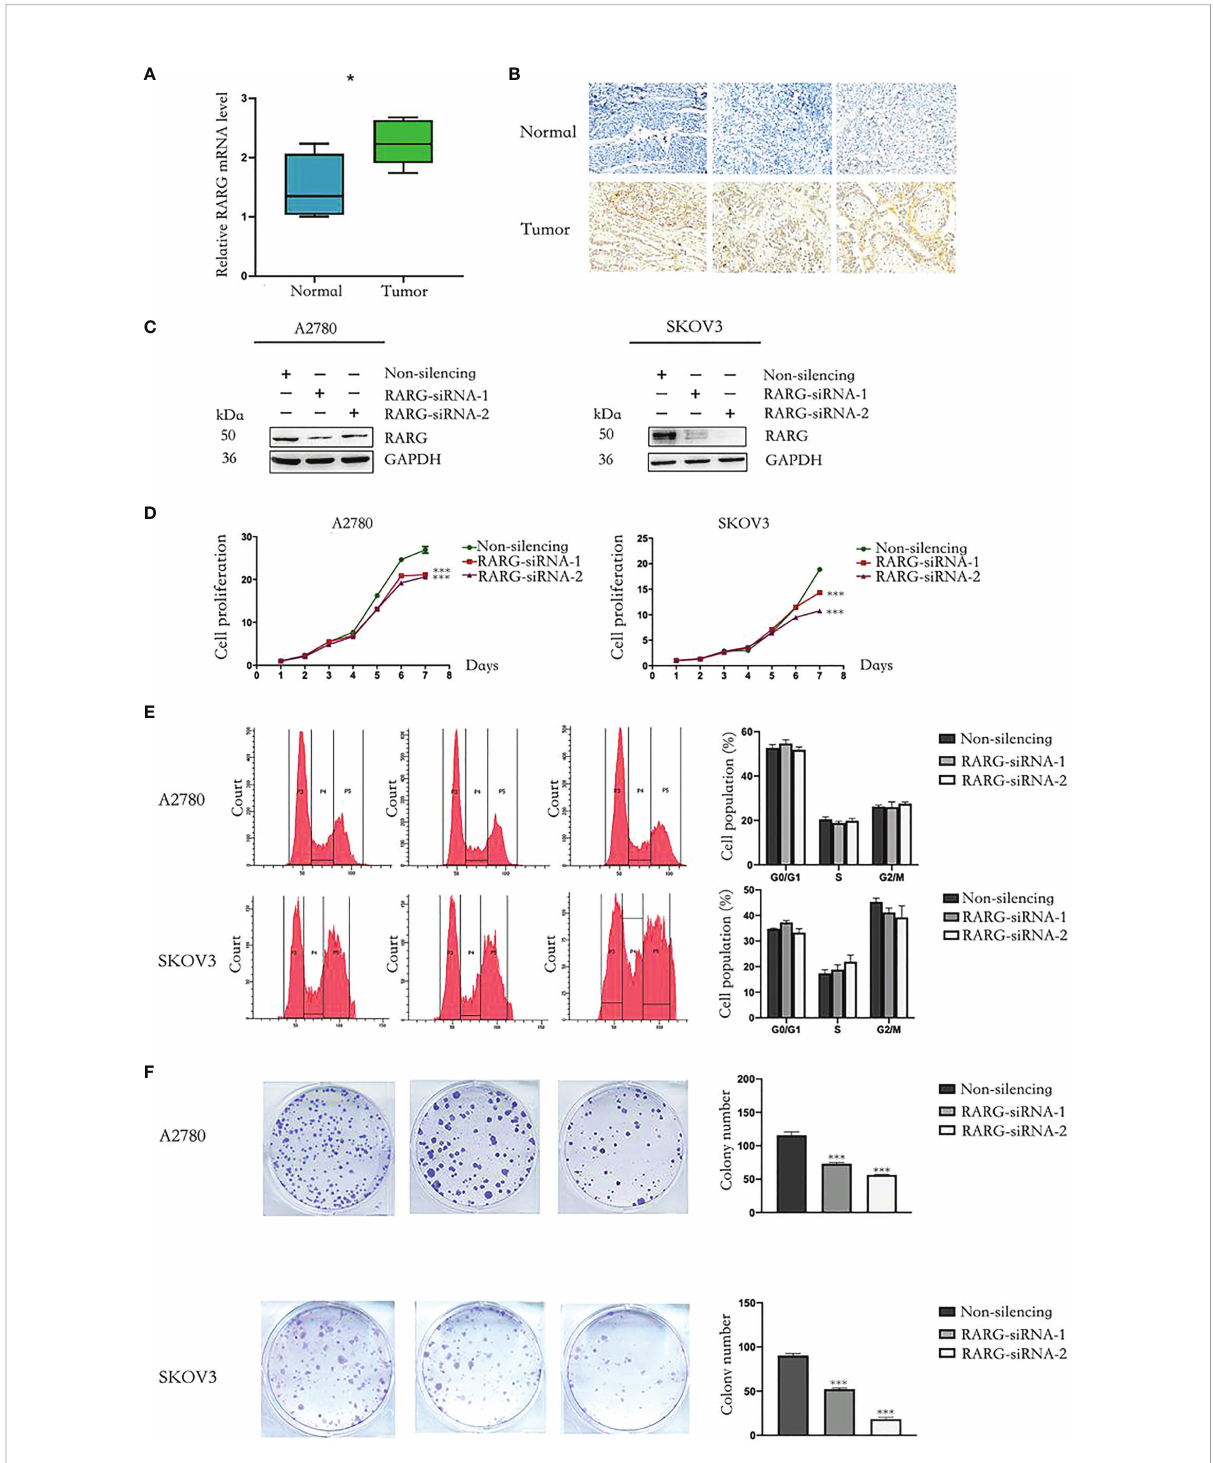
FIGURE 7 Downregulation of RARG inhibited proliferation of OC cells. (A) The qRT-PCR analysis of RARG mRNA levels in ovarian tumor tissues and adjacent normal tissues. (B) Immunohistochemistry analysis of RARG protein levels in ovarian tumor tissues and adjacent normal tissues. (C) Western blotting analysis of RARG expression in A2780 cells or SKOV3 cells transfected with RARG siRNA or non-silencing siRNA. (D) Cell proliferation was detected by the CCK-8 assay. (E) Cell cycle assay. (F) Cell Colony assay. *P < 0.05; ***P <